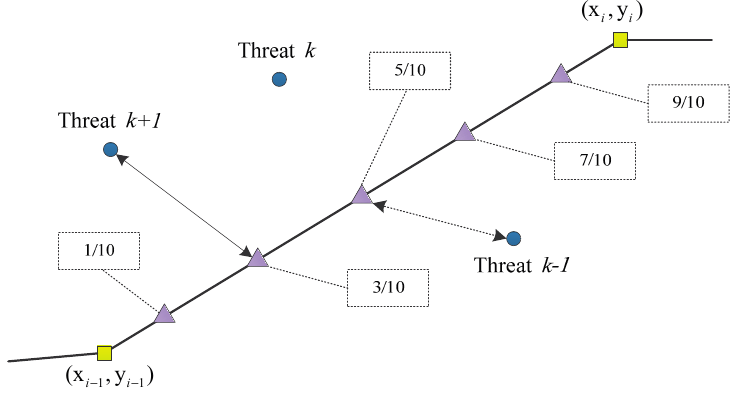
Figure 2. Computation for Threat